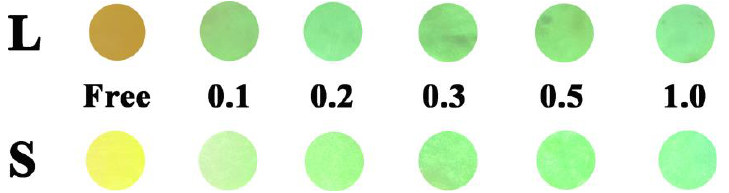
Figure 7. Fluorescence color changes of test strips for Al 3+ at different concentrations (0, 0.1, 0.2, 0.3, 0.5 and 1.0 mmol/L) under a UV lamp.